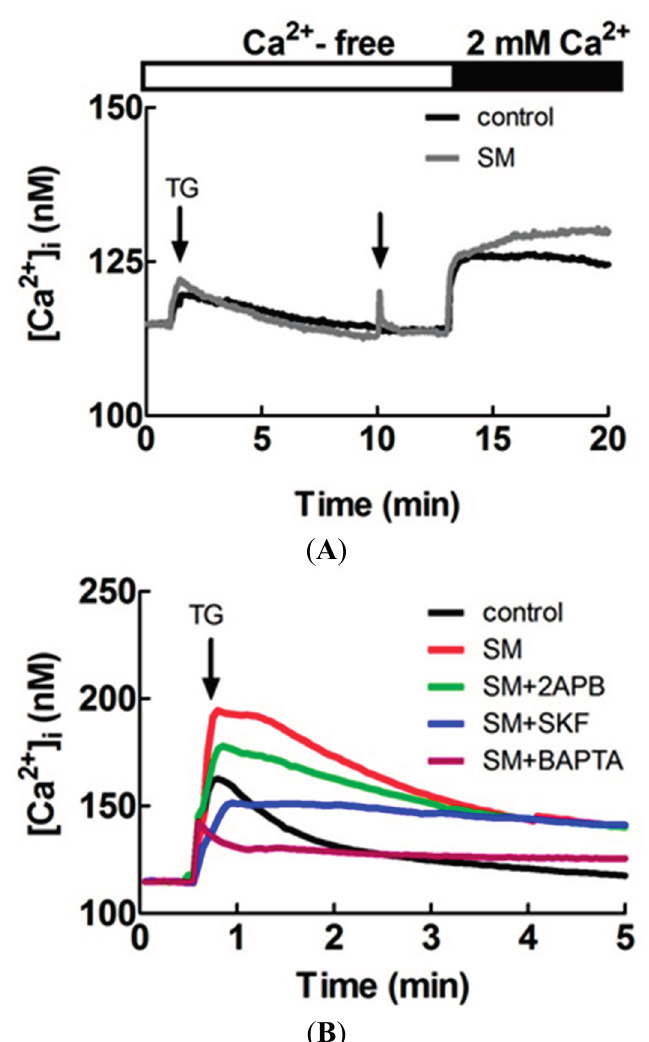
Figure 6. Effects of SM extracts on cytosolic concentration of free Ca 2+ ([Ca 2+ ] i ) in primary LES cells stained with fluo-4 acetoxymethyl ester and detected by the Olympus CellˆR. ( A ) 1 μ M thapsigargin (TG) treatment was performed at the 30th s and 0.5 μ L SM extracts stimulations or Ca 2+ -free BSS solution (control group) was added to 1 mL Ca 2+ -free BSS solution at the 10th min. The [Ca 2+ ] i in the SM extract stimulation group was more than the control group after addition of 2 mM CaCl 2 at the 13th min ( n = 3); ( B ) Primary LES smooth muscle cells were pretreated with 0.5 μ L SM extracts, 0.5 μ L SM extract with 20 μ M 2-aminoethoxydiphenyl borate (2APB), 0.5 μ L SM extracts with 2-aminoethoxydiphenyl borate (2APB), 0.5 μ L SM extracts with 20 μ M SKF-96365 (SKF), 0.5 μ L SM extracts with 25 μ M 1,2-bis(2-aminophenoxy)ethane- N , N , N ′ , N ʹ -tetraacetic acid tetrakis(acetoxymethyl ester) (BAPTA-AM), and 0.5 μ L BSS (control group) to 1 mL Ca 2+ -containing BSS solution. 1 μ M TG was applied to induce Ca 2+ influx at the 30th s The [Ca 2+ ] i in the group of only SM extracts pretreatment was more than the other groups ( n =